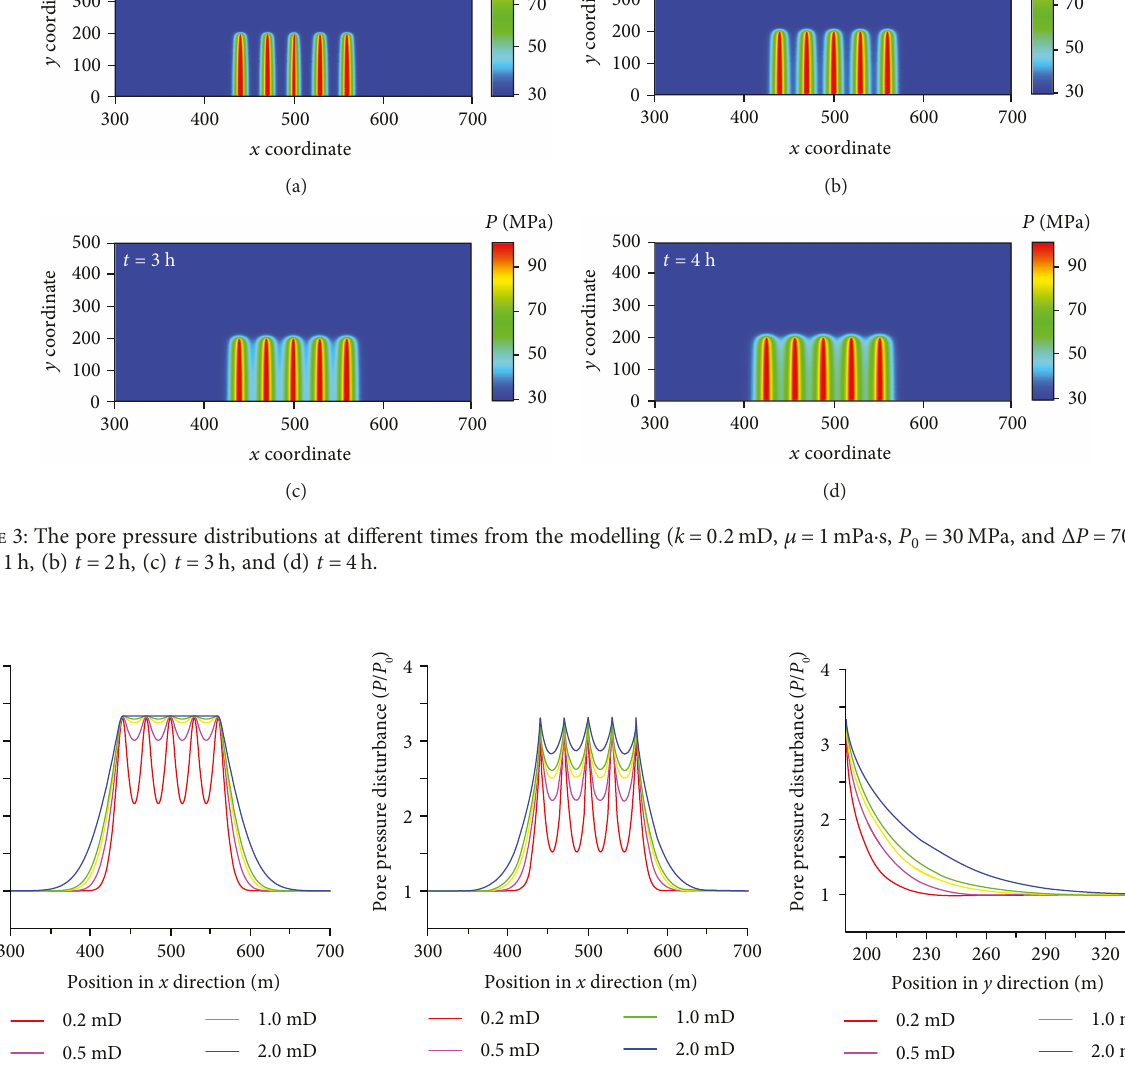
Figure 4: Pore pressure disturbance for di ff erent permeabilities at t = 4 h: (a) for data output line 1, (b) for data output line 2, and (c) for data output line 3.